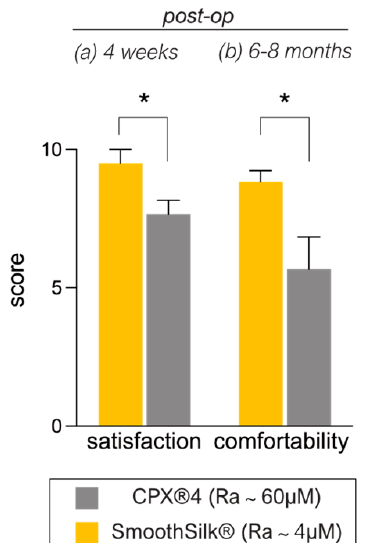
3.3. Patient-Reported Aesthetic and Comfort Outcome after Expander Reconstruction The patients’ rating of overall satisfaction with the expanders (Table 6) 4 weeks after implantation indicated a mean value of 9.57 (±1.13) for the SmoothSilk ® breast expander and 7.86 (±1.22) for the rougher CPX ® 4 device. Although patients report generally high satisfaction with the aesthetic outcome of both devices 4 weeks post-op, patients pre- sented more complaints about the comfortability (breast pain, breast discomfort, nipple sensitivity, and soreness) of CPX ® 4. The rating of expander comfortability after total expansion time, right before the ex- change to definite implants, indicated a mean value of 8.85 (±0.90) for the SmoothSilk ® breast expander and 6.00 (±2.77) for the rougher CPX ® 4 device. Hence, both patient-reported aesthetic and comfort outcome were significantly higher rated for the SmoothSilk ® breast expander (Figure 4; satisfaction after 4 weeks: p * = 0.036; comfortability after 6–8 M: p * = 0.036).